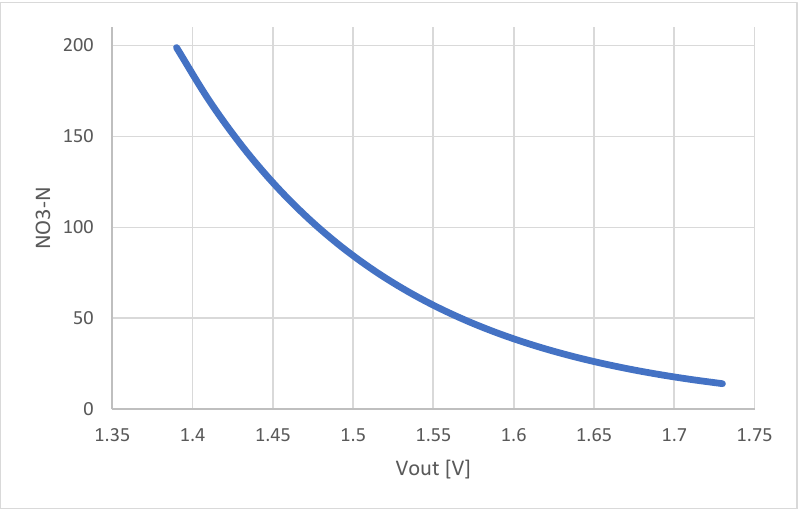
Figure 10. Calibration curve that relates ISE probe voltage output with nitrate-nitrogen concentration.